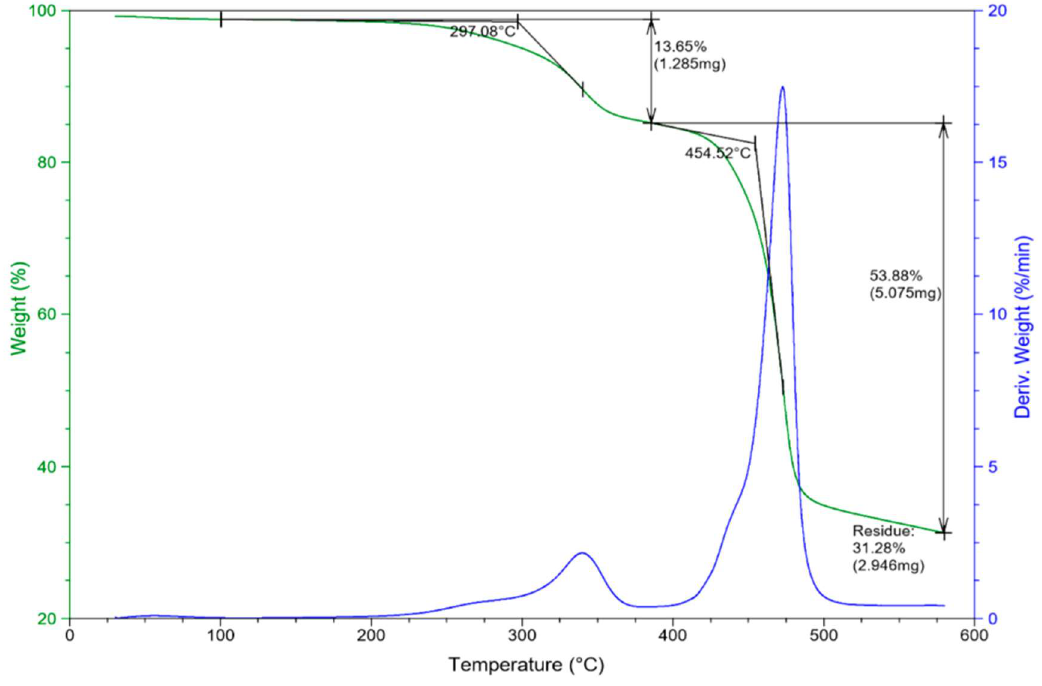
Figure 6. Thermogravimetric plot analysis of PVDF–SSPF composites.